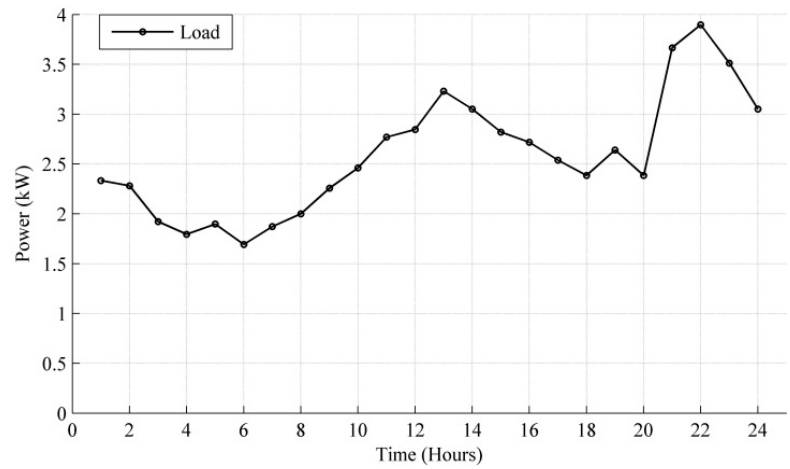
Figure 5. Load profile of Taroa, La Guajira, Colombia.